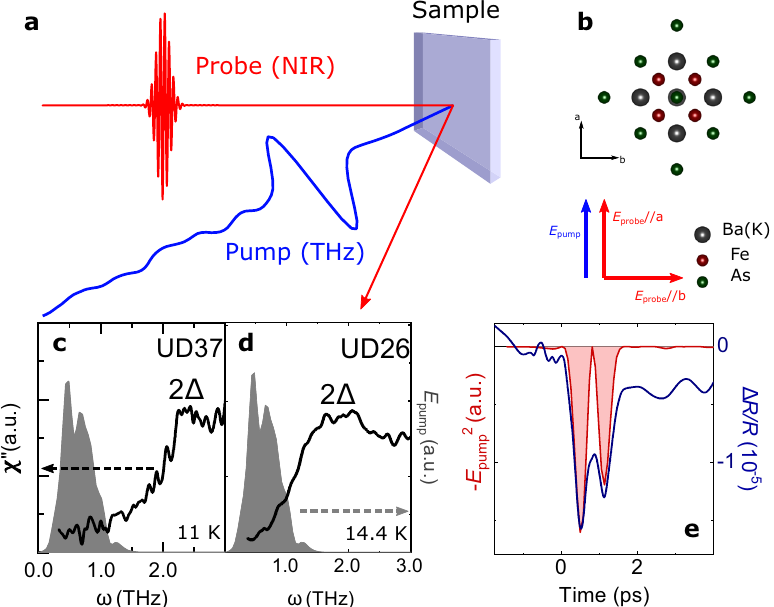
Fig. 1 Nonlinear THz response in Ba 1 − x K x Fe 2 As 2 . a Sketch of the THz pump near-infrared (NIR) probe measurements. b Crystal structure of BaFe 2 As 2 and the two polarization con fi gurations used to determine the C 4 symmetric and nematic components of the transient re fl ectivity. Raman spectra of Ba 1 − x K x Fe 2 As 2 in the B 1g symmetry for UD37 ( c ) and UD26 ( d ) below T c . 2 Δ indicates superconducting gap from the hole pockets. The gray curve represents the energy spectrum of the THz pump. e For UD37, Δ R / R (blue line) along one of the Fe – Fe axis at 20 K ( T < T c ) as a function of delay time between the pump and probe pulses. The instantaneous component that follows E 2 component corresponds to the THz Kerr